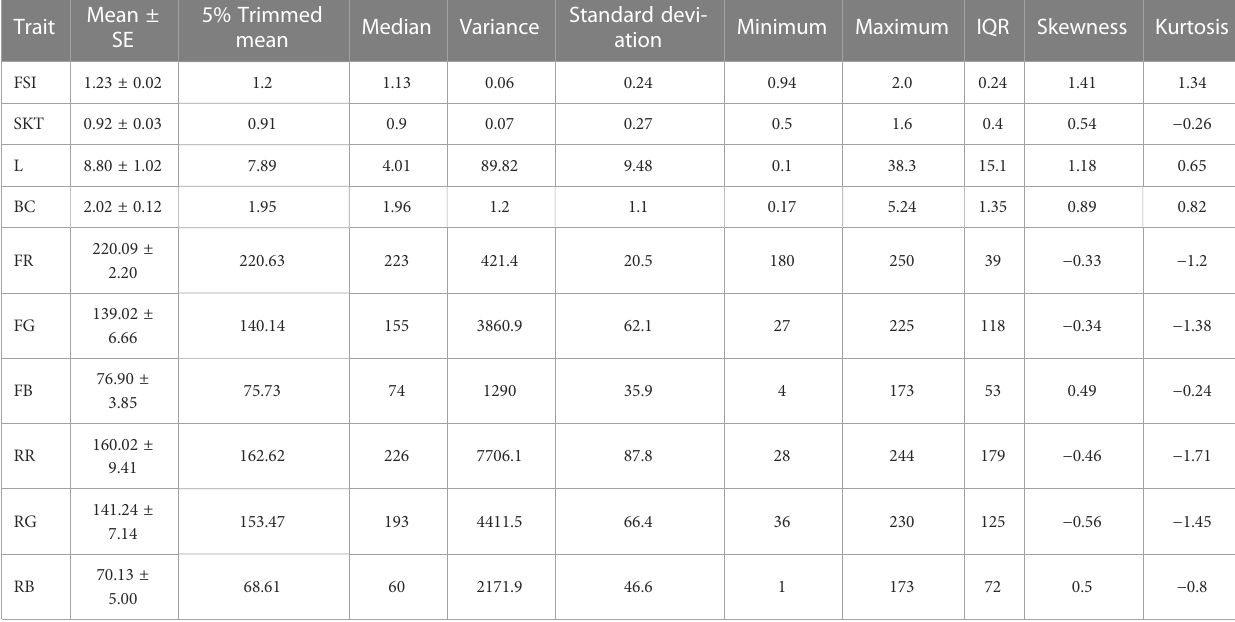
TABLE 2 Descriptive statistics of the traits investigated in the F 2